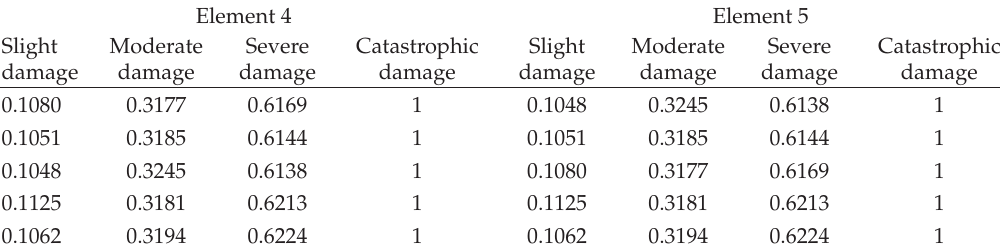
Table 5: Knowledge base for damage identification of missing information at node